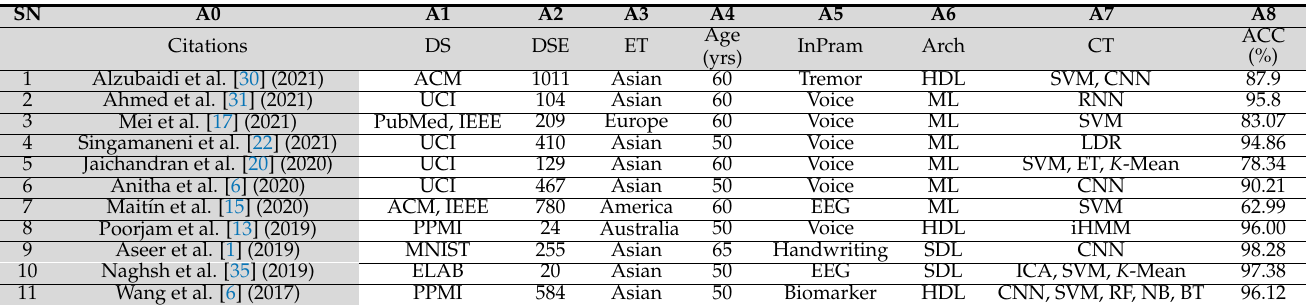
Table A2. Studies vs. Attributes.